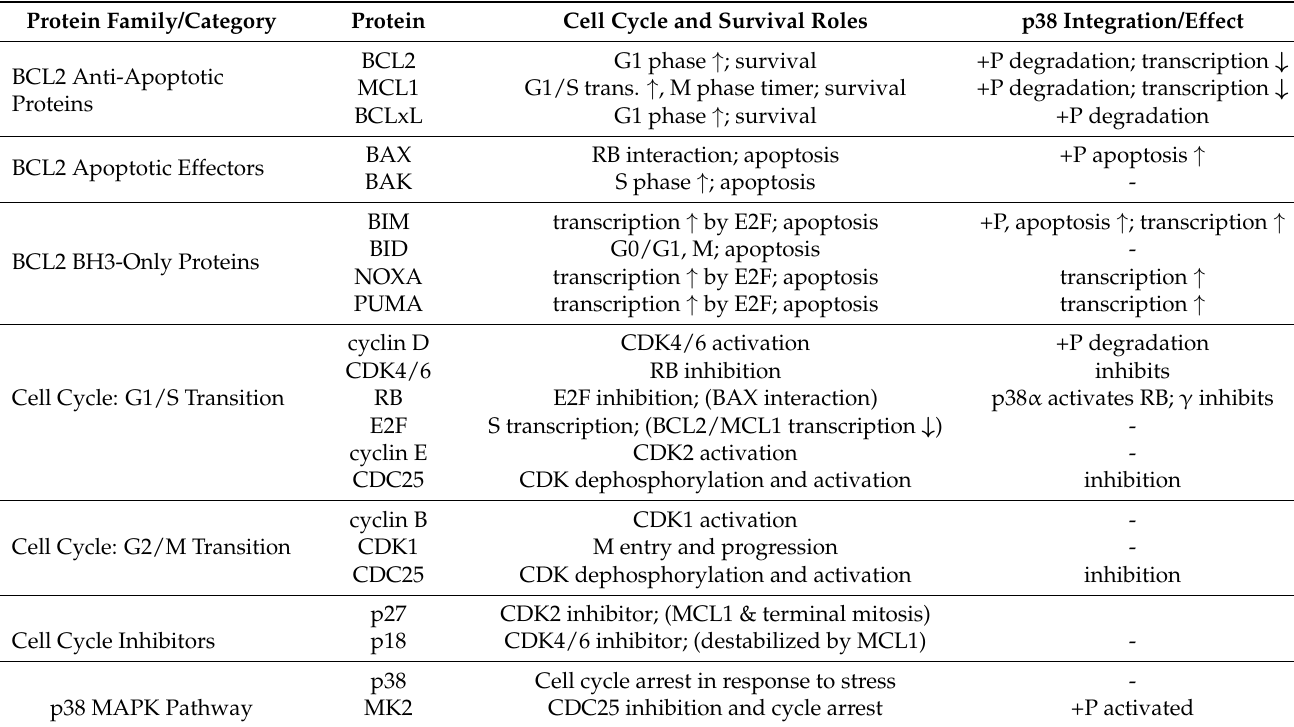
Table 1. List of key proteins discussed in the text (relevant references in the